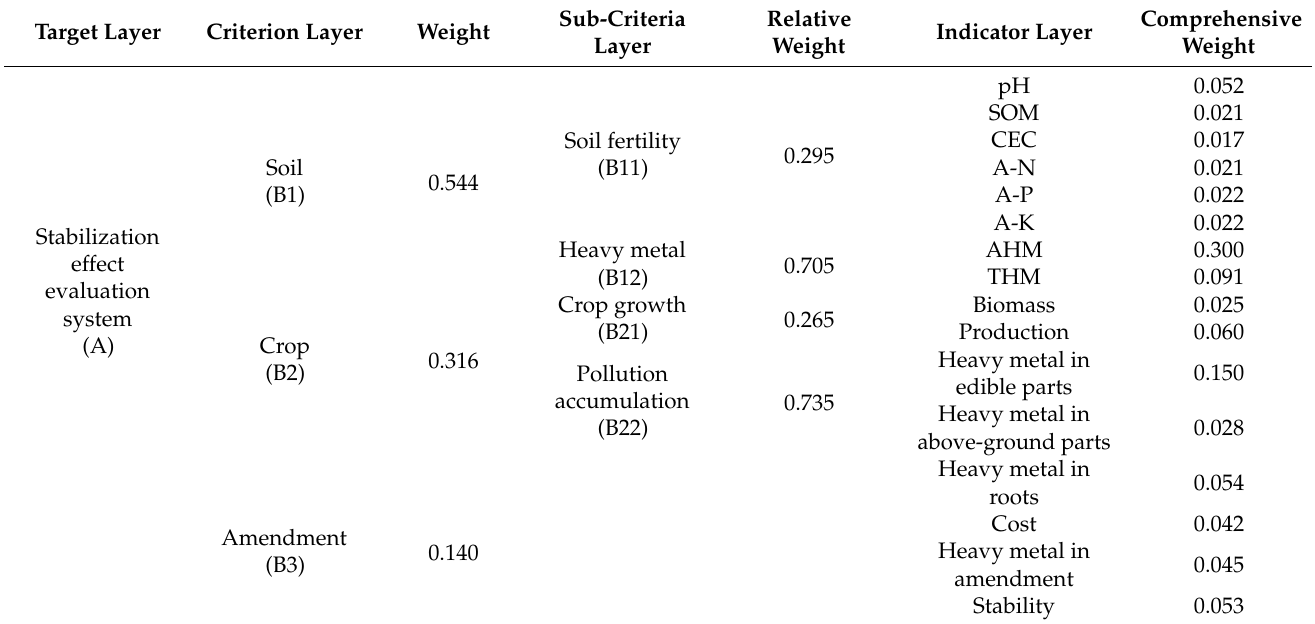
Table 3. Evaluation system and indicator weight.